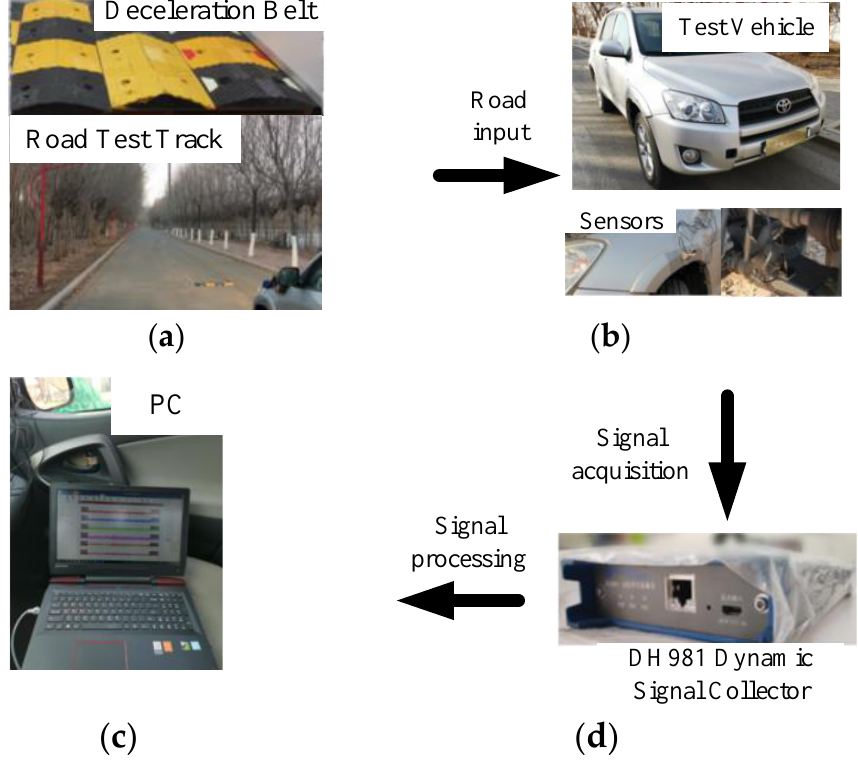
Figure 6. Road test of the vehicle. ( a ) vehicle test ground; ( b ) experimental vehicle; ( c ) computer; ( d ) dynamic signal collector.